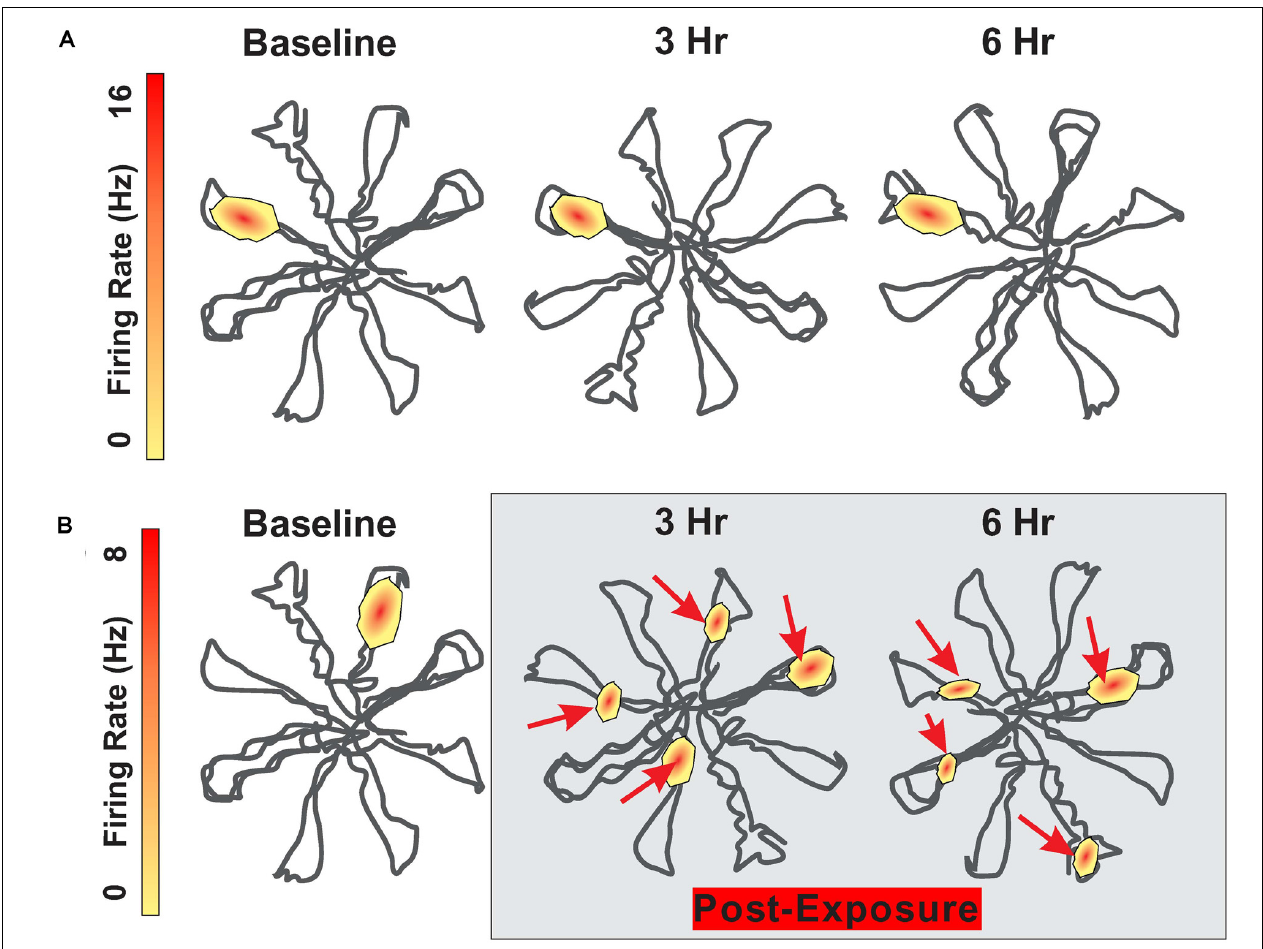
FIGURE 3 | Schematic showing firing pattern of place cells in the hippocampus as rat navigates through an eight-arm radial maze. (A) Schematic showing place cell firing pattern within the radial maze; place at which the cell fires remain relatively stable between baseline and 3 h and 6 h later. (B) Schematic showing place cell firing pattern at baseline and then 3 h and 6 h following 30 min exposure to 104 dB SPL 4 kHz tone. Location of place cell firing locations drastically altered after the noise exposure. Maximum firing rate on upper and lower heat maps is 16 Hz and 8 Hz